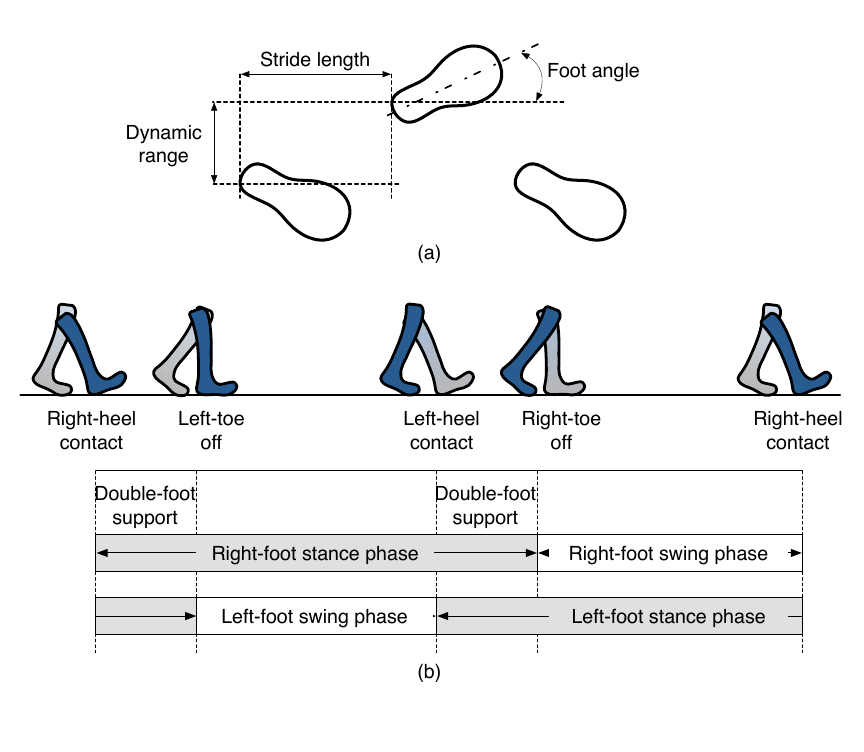
Figure 1. Examples of walking pattern in gait: (a) stride length, dynamic range, foot angle (b) stance time and swing